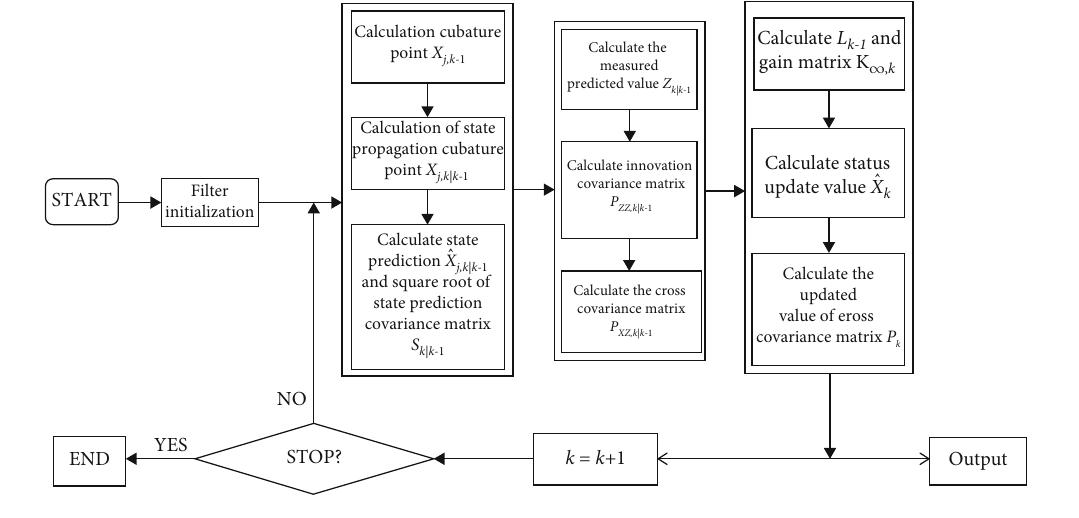
Figure 4: SR-CH ∞ KF fl owchart. Table 1: Geomagnetic parameters. Table 2: Simulation